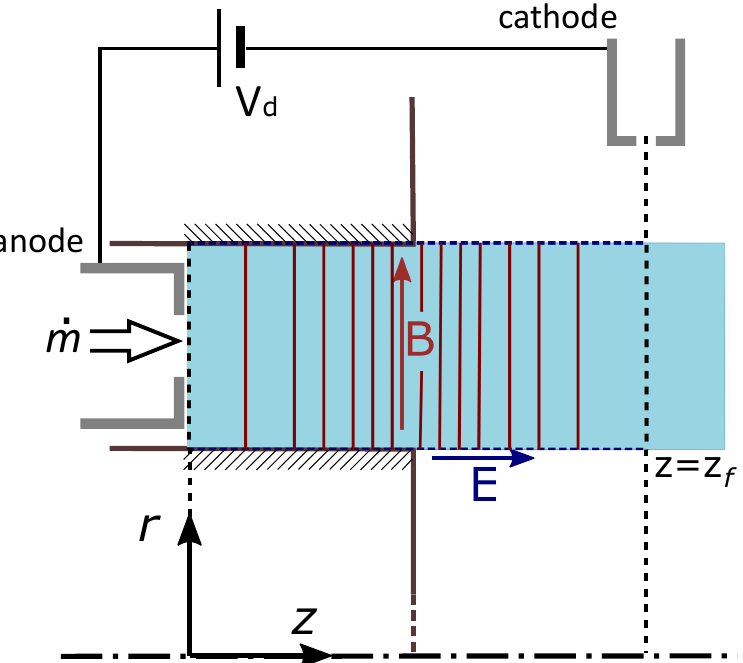
Figure 1. Schematic representation of the simulation domain, highlighting the main features of a Hall